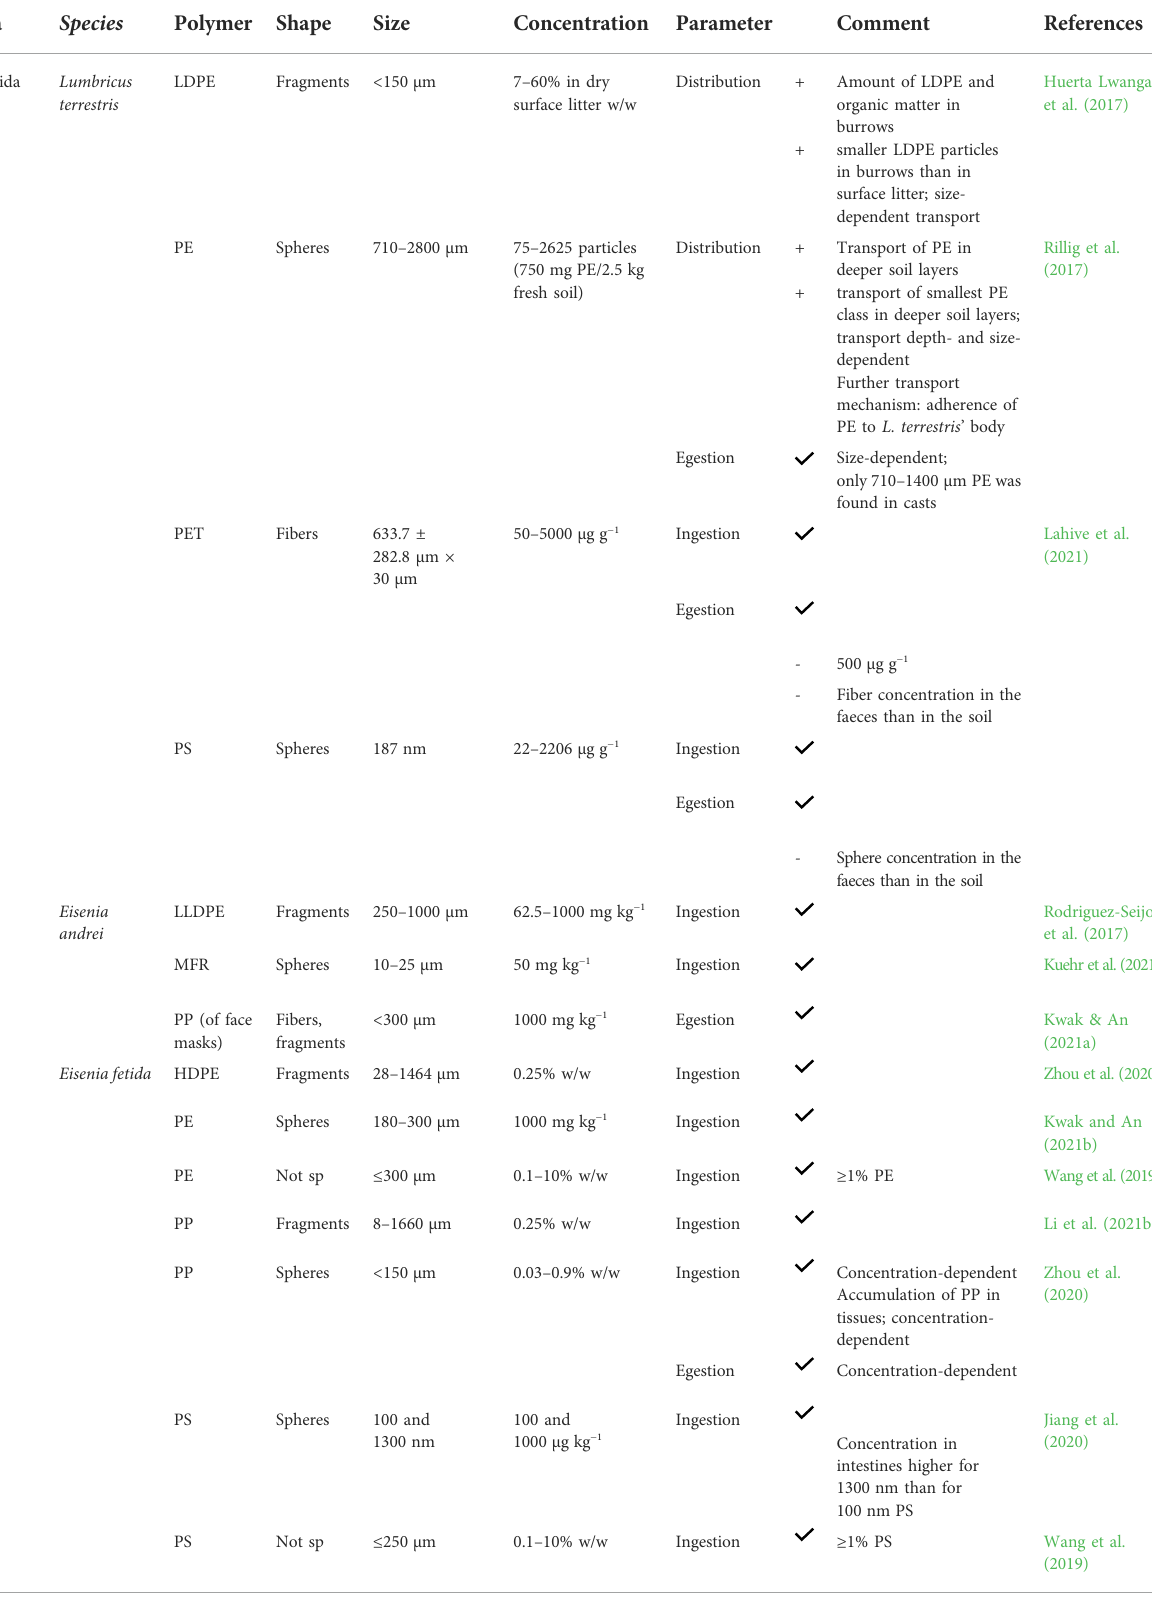
TABLE 1 Ingestion, egestion and distribution of microplastics through soil